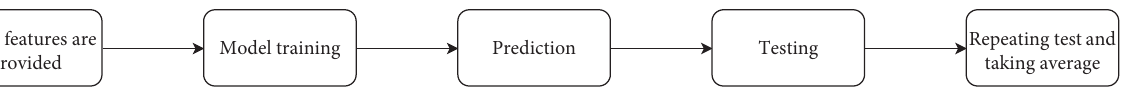
Figure 3: Steps for training the classification model.